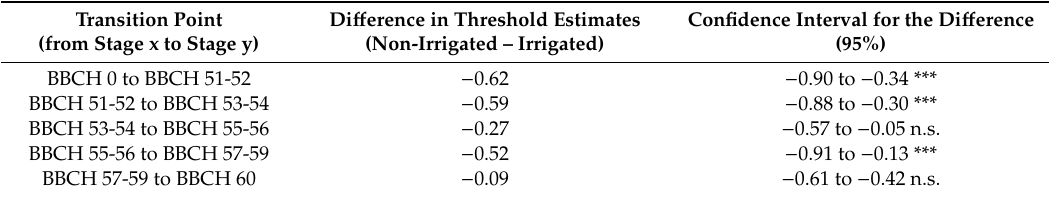
Table 2. Di ff erences between estimated thresholds for transition points between non-irrigated and irrigated buds through cumulative link modelling. Data in the confidence interval column reflects results on significance from Wald’s test (z-value). ‘***’ indicates p < 0.05, while ‘n.s.’ means that treatments were not significantly di ff erent at this confidence